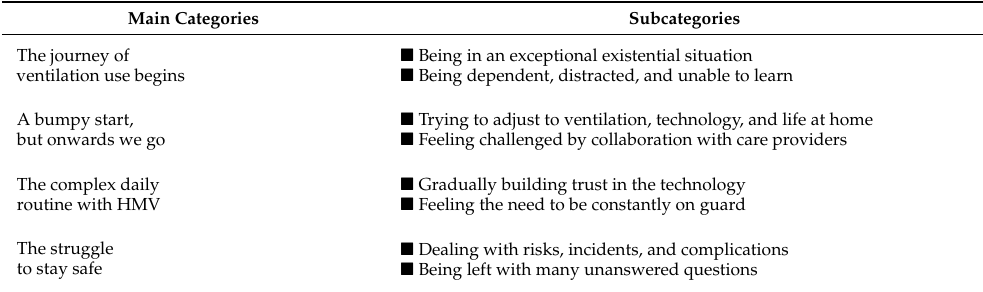
Table 3. Four main categories and eight